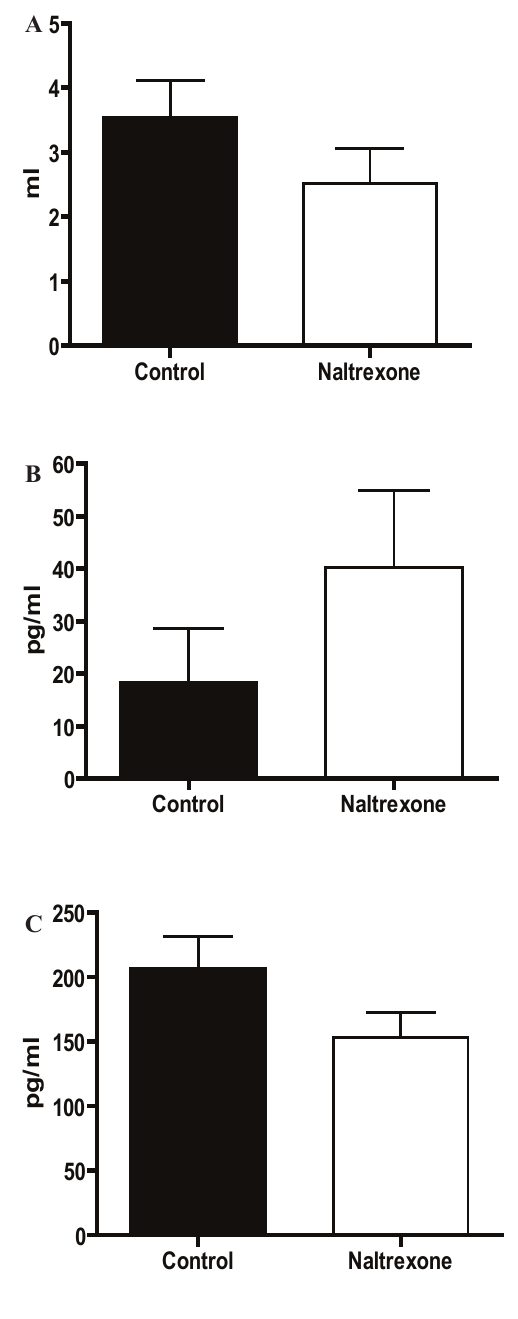
FIGURE 2 - Ascitic fluid volume and Inflammatory cytokines. AP was induced in rats by intraductal injection of 0.5ml of 2.5% taurocholic acid. Control group received saline solution administration 15 minutes before AP induction and Naltrexone group received naltrexone (15mg/Kg) 15 minutes before AP induction. Ascitic fluid volume (A) Concentration of peritoneal TNF-α (B) Serum IL-6 levels (C) Data are expressed as mean ± SEM of nine animals per group.